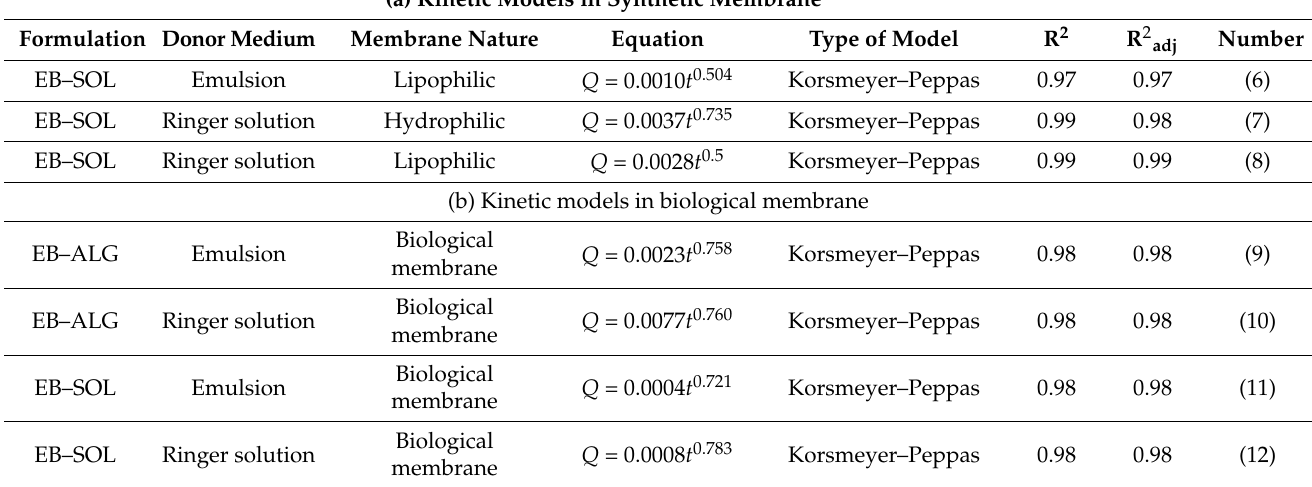
Table A2. Cont. (a) Kinetic Models in Synthetic Membrane